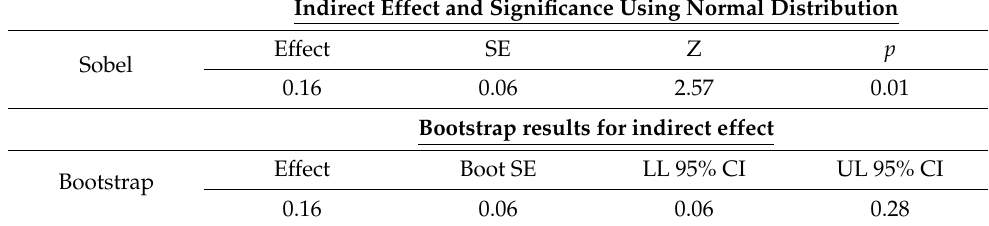
Table 3. Indirect effect of coworkers’ helping behavior on creativity through employees’ knowledge